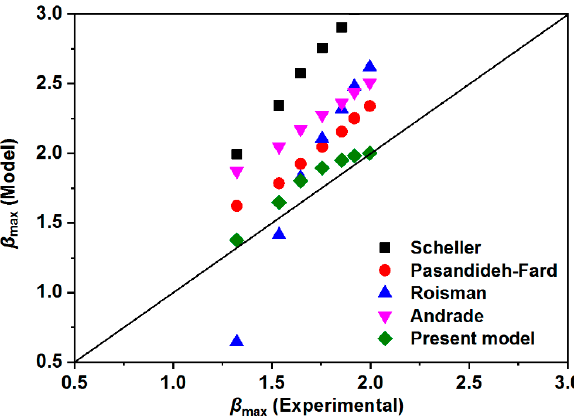
Table 1. Different proposed models for the maximum spreading factor.